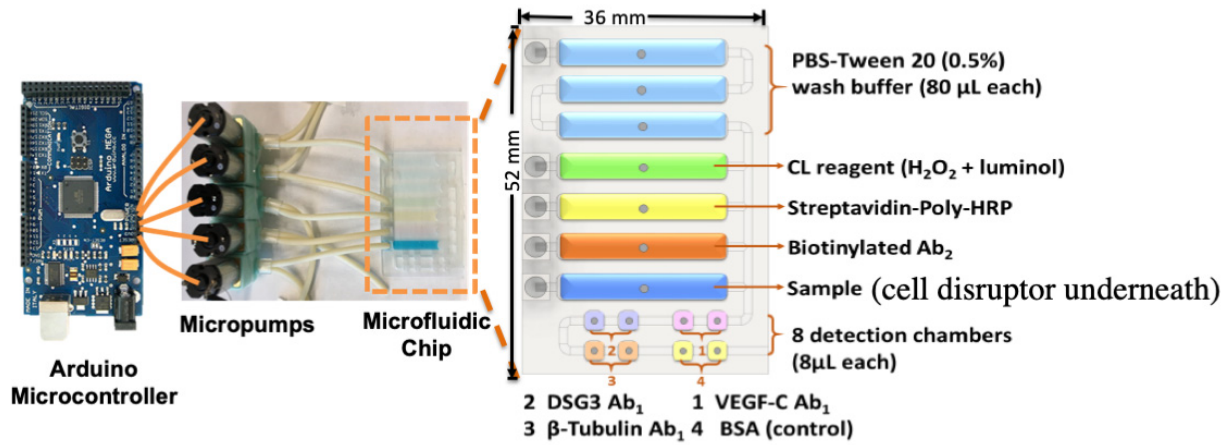
Figure 7. Microfluidic immunoarray for cell disruption and protein detection. The design features a microfluidic chip with five inlets connected to peristaltic micropumps, sample and rectangular prism reagent chambers with capacity of 80 ± 5 µ L, and eight cylindrical detection chambers with 8 ± 1 µ L capacity each. The microfluidic chip houses sample and reagents and delivers them sequentially to the detection compartment. The assay protocol utilizes poly-HRP and ultra-bright femto-luminol to produce chemiluminescence (CL) that is captured in a dark box using a CCD camera. The microfluidic chip is mounted on the housing device support equipped with a sonic cell disruptor that achieves cell lysis. Programmable micropumps are connected to microfluidic chip sample and reagent chambers and the assay is automated by using an Arduino microcontroller that control pump on/off cycles. Adapted from [43], with permission. Copyright Elsevier,